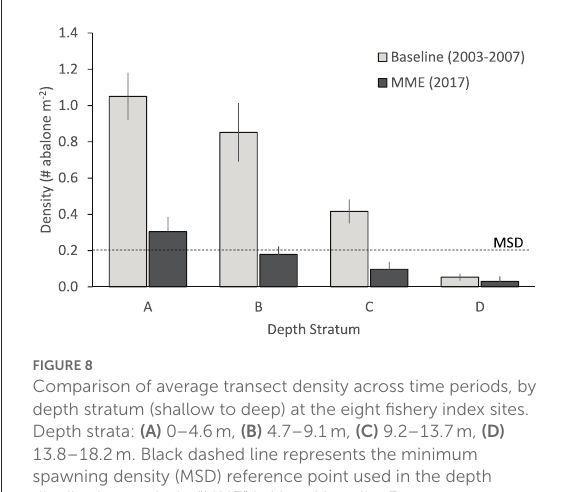
FIGURE8 Comparison of average transect density across time periods, by depth stratum (shallow to deep) at the eight fishery index sites.